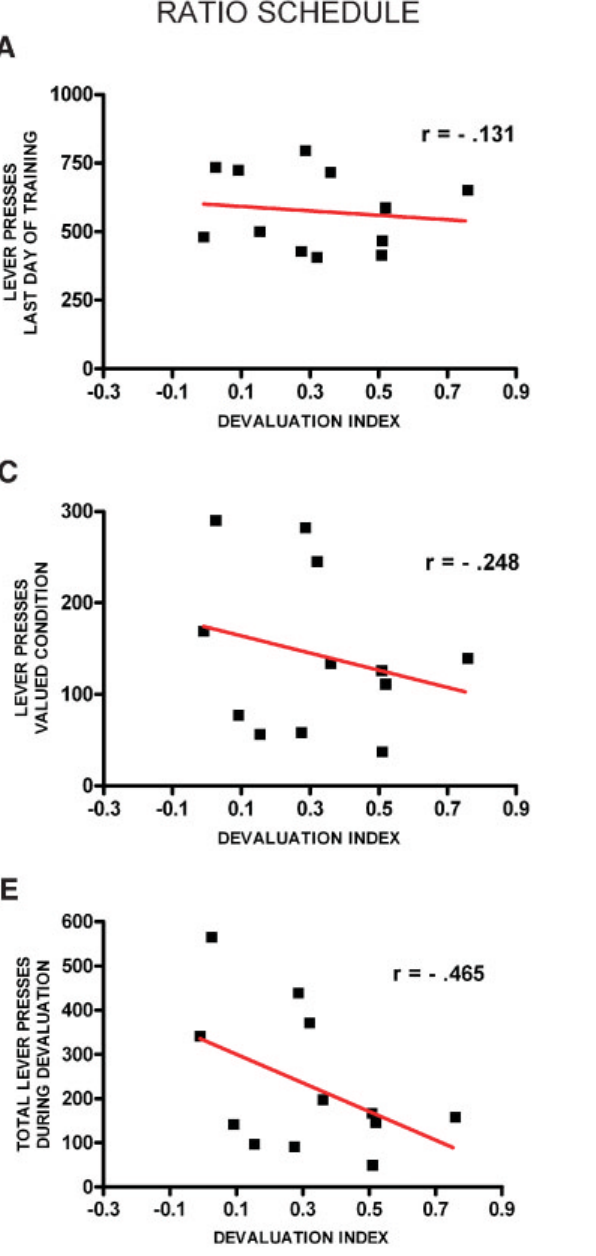
press a novel lever identical to their training lever ( Figure 4 ). We trained twodifferentgroupsofmiceinrandomratioandrandomintervalschedules and tested their propensity to exploit the training lever versus explore a novellever.Consistentlywiththepreviousexperiment,allanimalsacquired the task ( F 6,84 = 20.5, p <0.001), with no significant interaction between acquisition and schedule of reinforcement ( F 6,9 = 2.89, p = 0.07). In this experiment mice trained on a random ratio schedule did press at higher rates than mice trained on a random ratio interval schedule ( F 1,14 = 12.8,